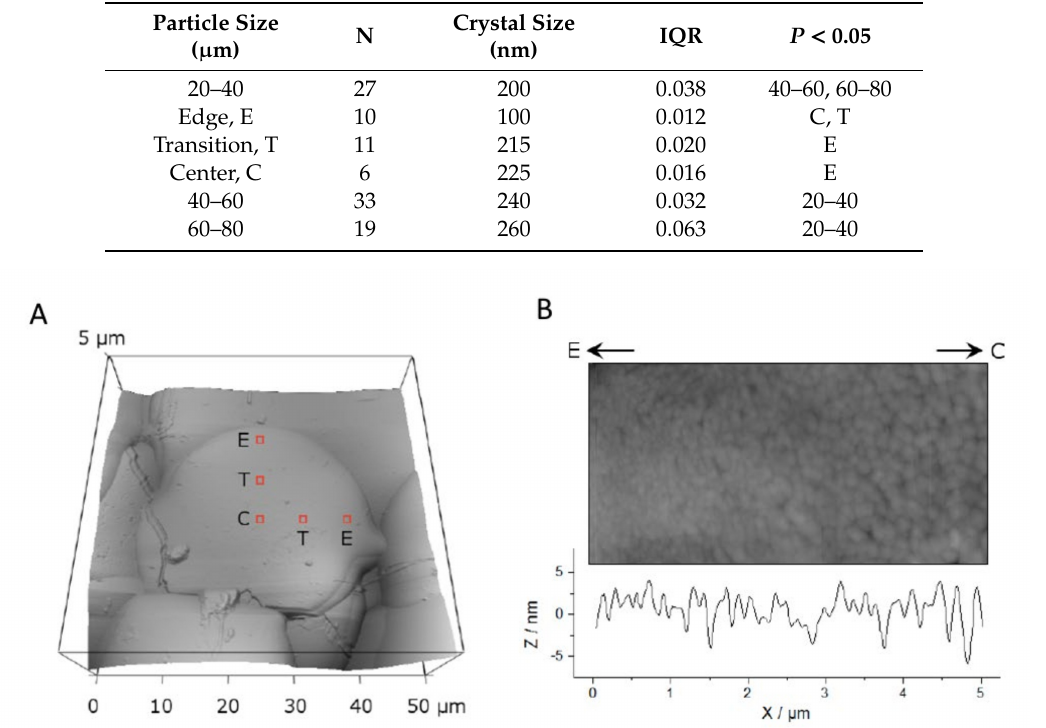
Figure 8. AsplatvisualizedbyAFM( A )outliningthreeanalysispositionsand( B )showinganenlargedview. Along the direction from the center (C) to the edge (E) to reveal a gradual increase in crystal size towards the